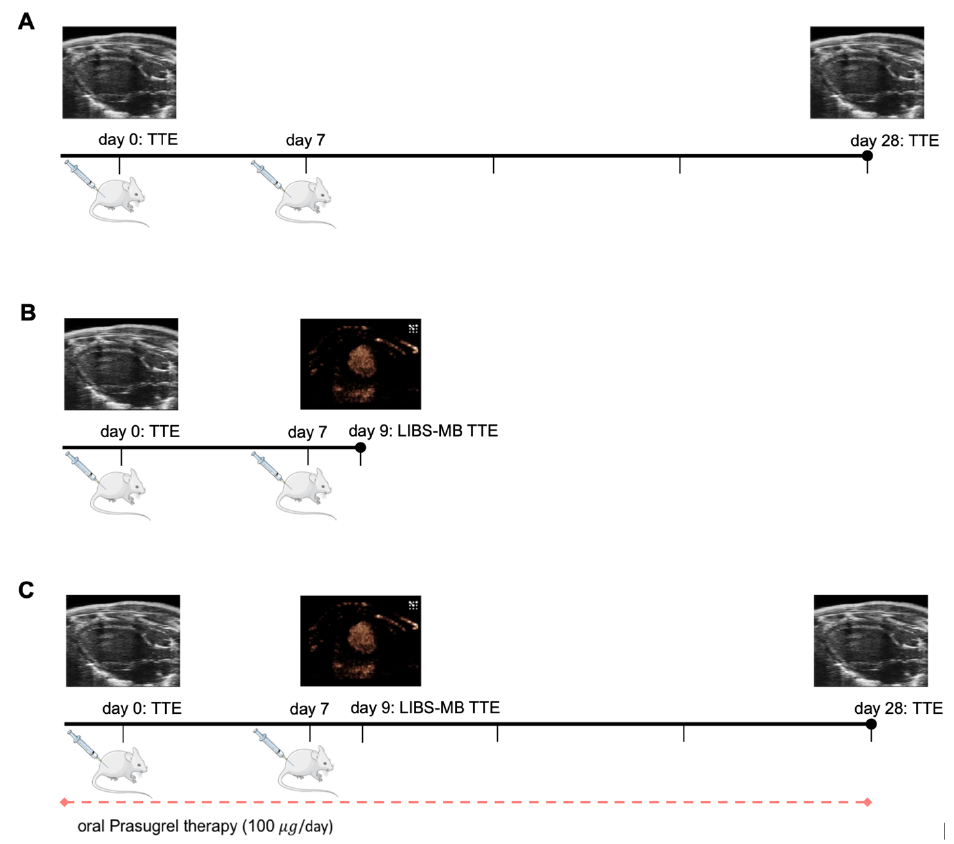
Figure 1. Study design. ( A ) Cardiac function trial: Porcine cardiac myosin was injected subcuta- neously (s.c.) in BALB/c mice with CFA (myocarditis group) and without CFA (control group) at day 0 and day 7. Echocardiography to evaluate the left ventricular ejection fraction (EF) was performed on day 0 and day 28. Thereafter, mice were sacrificed for histology. ( B ) LIBS-MB trial: EAM induction (Myocarditis group) at day 0 and day 7 alongside native echocardiography on day 0 and day 9 with contrast echocardiography using LIBS-MB/control-MB on day 9. ( C ) Prasugrel therapy trial: EAM was induced at day 0 and day 7 combined with 1 month of oral prasugrel application by daily oral gavage. Native echocardiography was performed on day 0, day 9, and day 28. Contrast echocardiography using LIBS-MB/control-MB was performed on day